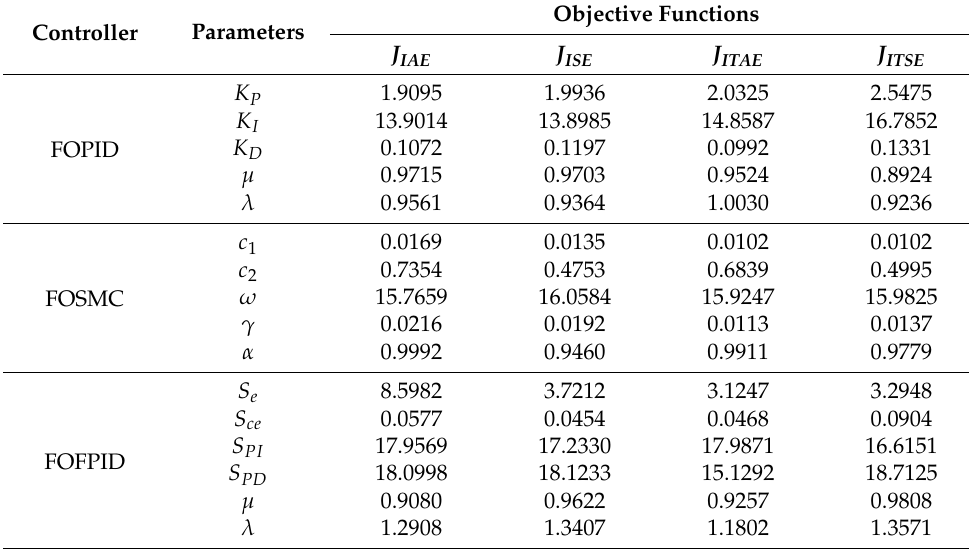
Table 3. Optimized controller parameters based on different objective functions for the Maglev System.